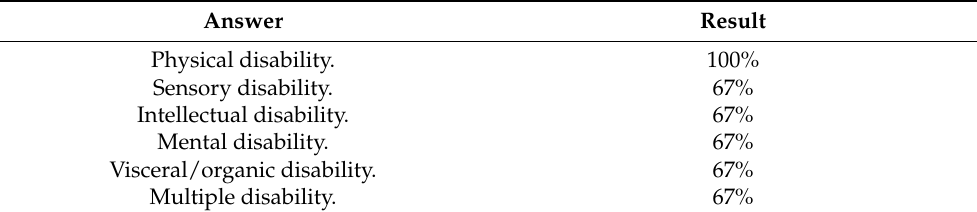
Table 5. What type or types of disability do most of your workers with disabilities have? (Check one or more answers). Answer Result Physical disability. 100% Sensory disability. 67% Intellectual disability. 67% Mental disability. 67% Visceral/organic disability. 67% Multiple disability. 67%